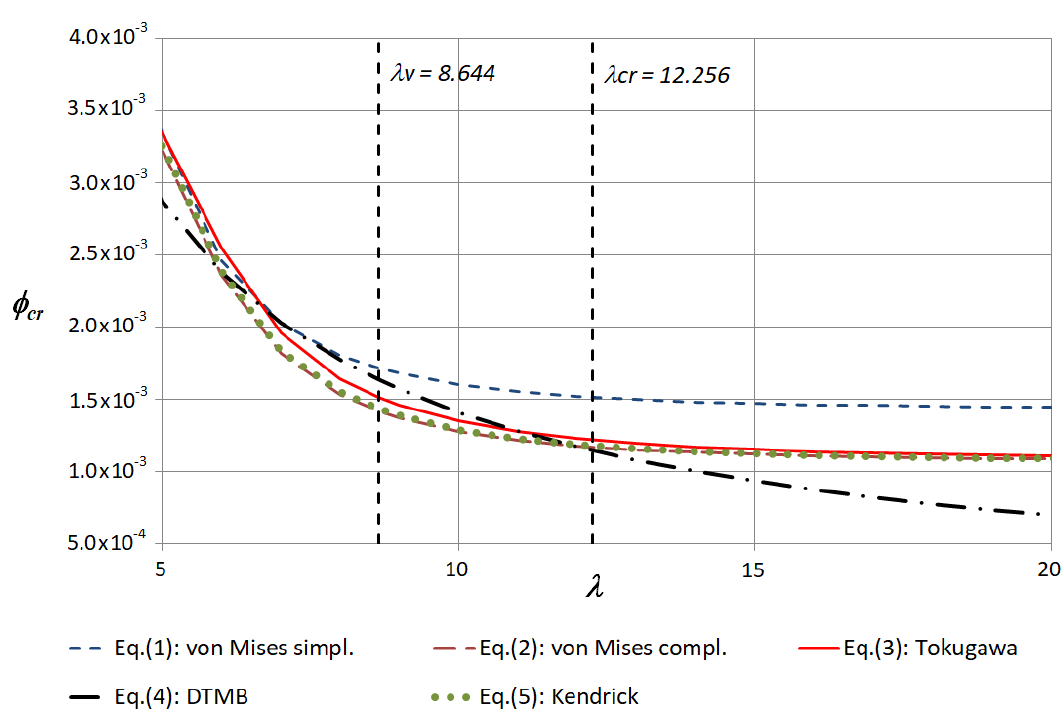
=  (  ) for 1 ≤  ≤ 100 . 𝑐𝑟 𝑐𝑟